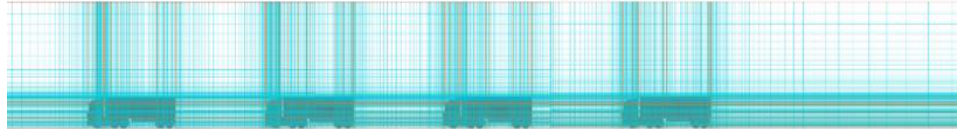
Figure 3. A typical numerical grid with the four model vehicles in platooning (658 × 99 × 87).